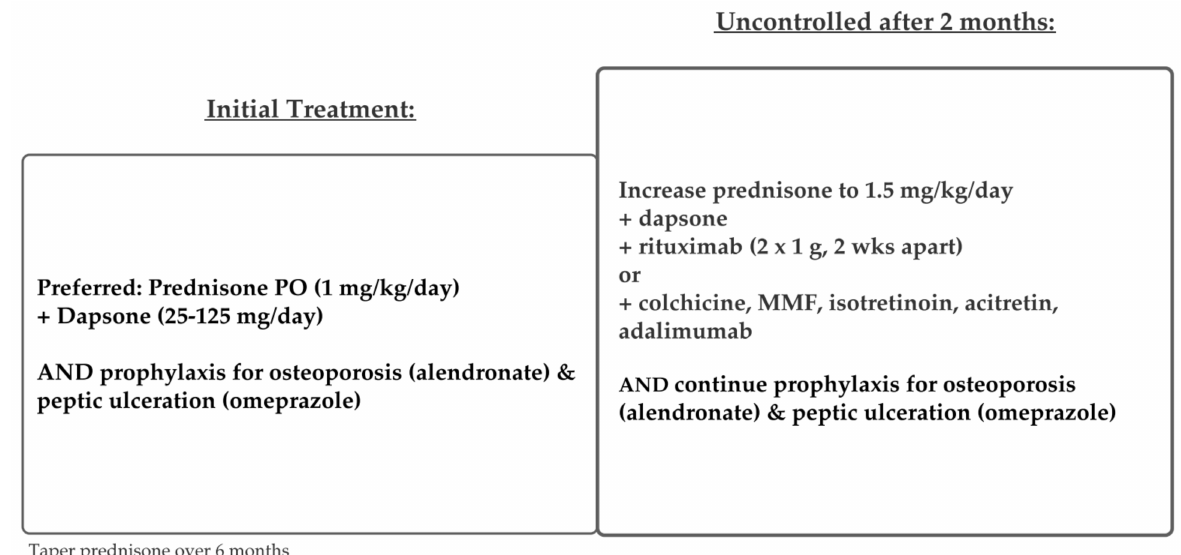
Figure 7. Treatment schema for IgA